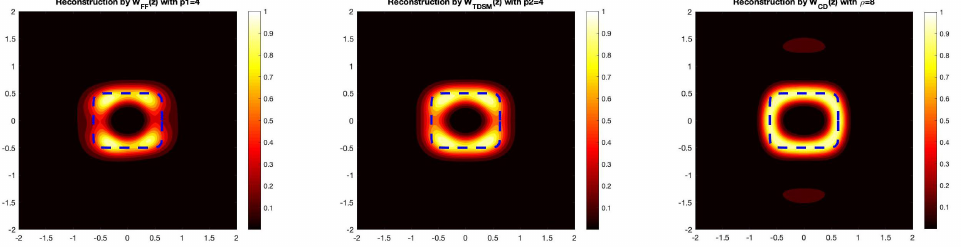
Figure 4. The reconstruction of the rounded square by the three direct sampling imaging functionals. In this example, we take δ = 0.05, which corresponds to a 5% noise level.